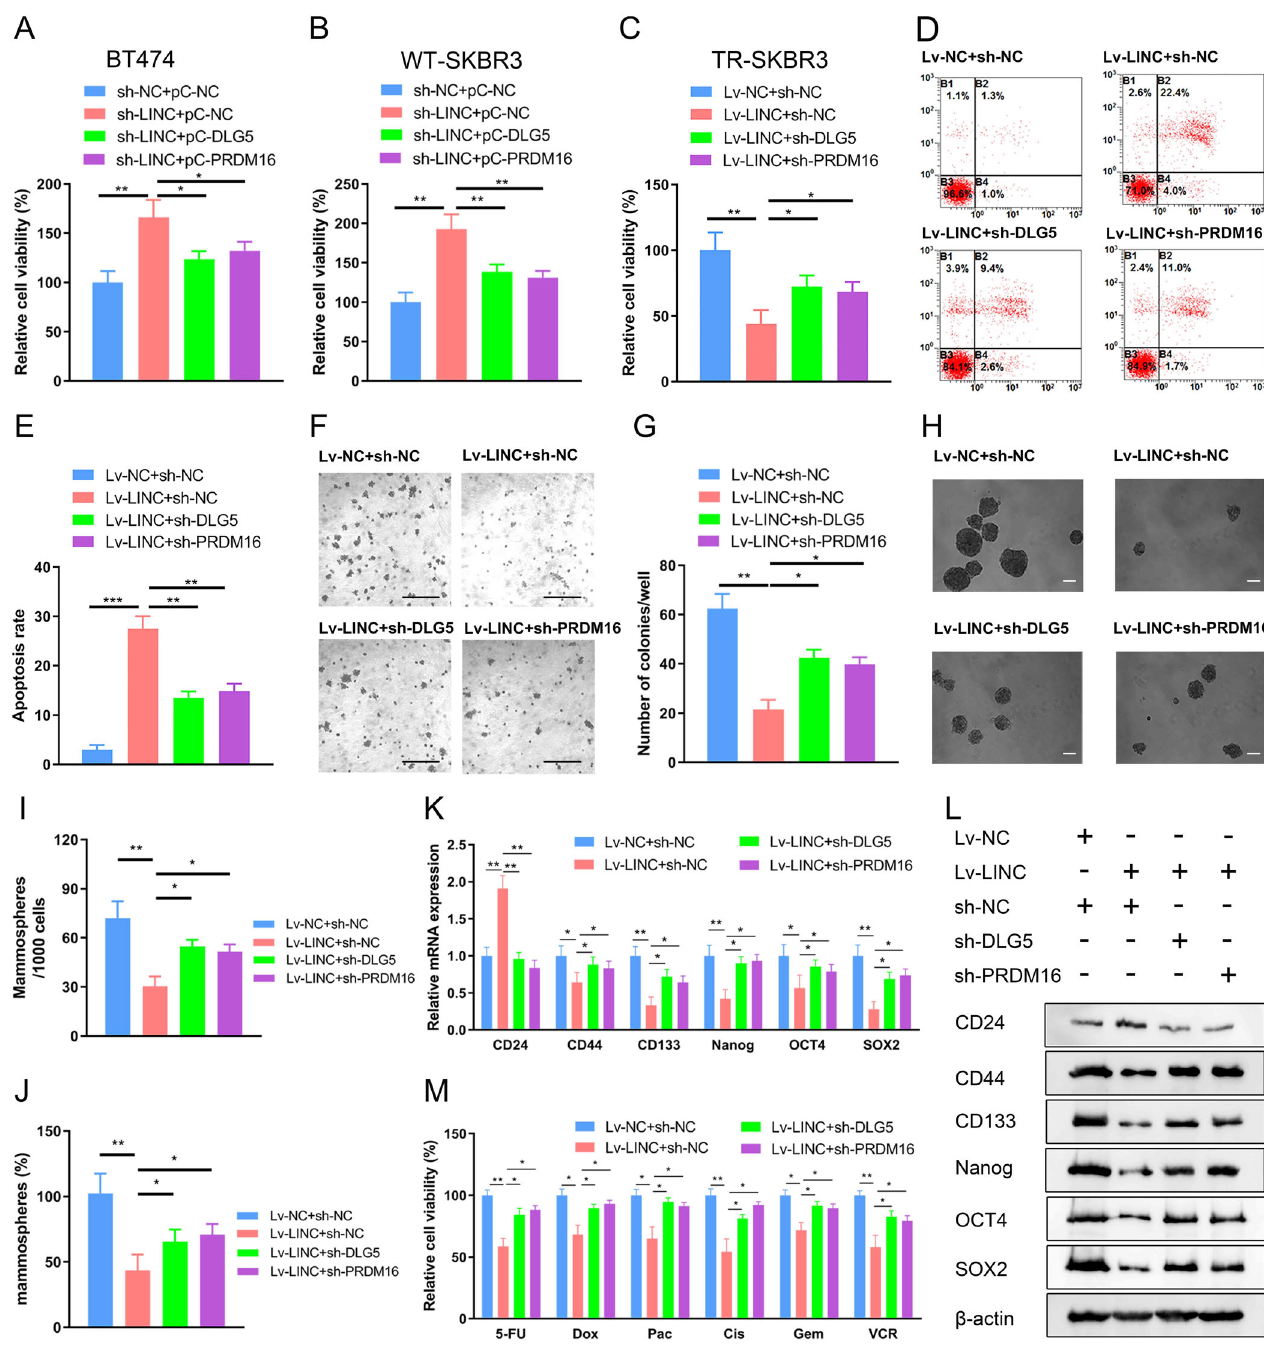
Fig. 7 LINC00589 represses trastuzumab resistance, cancer stem cell-like properties, and multiple chemoresistance via DLG5 and PRDM16 . A – E WT SKBR3 and BT474 cells infected with sh- LINC00589 or sh-NC lentivirus were transfected with pCDNA (pC) - DLG5 or pC- PRDM16 for 48 h; or TR SKBR3 cells infected with Lv- LINC00589 or the Lv-NC were transfected with sh- DLG5 or sh- PRDM16 for 48 h. The relative cell viabilities of WT SKBR3 cells ( A ), BT474 cells ( B ) and TR SKBR3 cells ( C ) were quanti fi ed by CCK-8 assay. Apoptosis of TR cells were examined by fl ow cytometry assay ( D ) and the apoptosis rate was calculated ( E ). F – M LINC00589 - or NC- overexpressing TR cells were infected with sh- NC, sh- DLG5 or sh- PRDM16 lentivirus. Cells were cultured in soft agar for 21 days, representative images of colony formation were observed ( F ), and the number of colonies were calculated ( G ). Scale bar 100 μ m. Cells were seeded in an ultra-low-attachment culture system. Represent images of mammosphere formation were observed ( H ), and numbers ( I ) and volumes ( J ) of mammospheres were calculated. Scale bar 100 μ m. Data are shown as the mean ± SD of fi ve random high-power fi elds (HPF) and were analyzed by two-tailed t test. * P < 0.05, and ** P < 0.01. mRNA and protein expression of molecular markers of breast cancer CSCs were determined by qRT-PCR assay ( K ) and western blotting ( L ). GAPDH and β -actin were used as internal controls. M Cells were exposed to 5-FU, Dox, Pac, Cis, Gem, or VCR for 48 h, and the cell viability was evaluated by CCK-8 assay. Data are shown as mean ± SD; two-tailed t test was used to analyze the data in ( A , B , C , E , K , and M ). * P < 0.05, ** P < 0.01, and *** P < 0.001 versus negative control (NC).